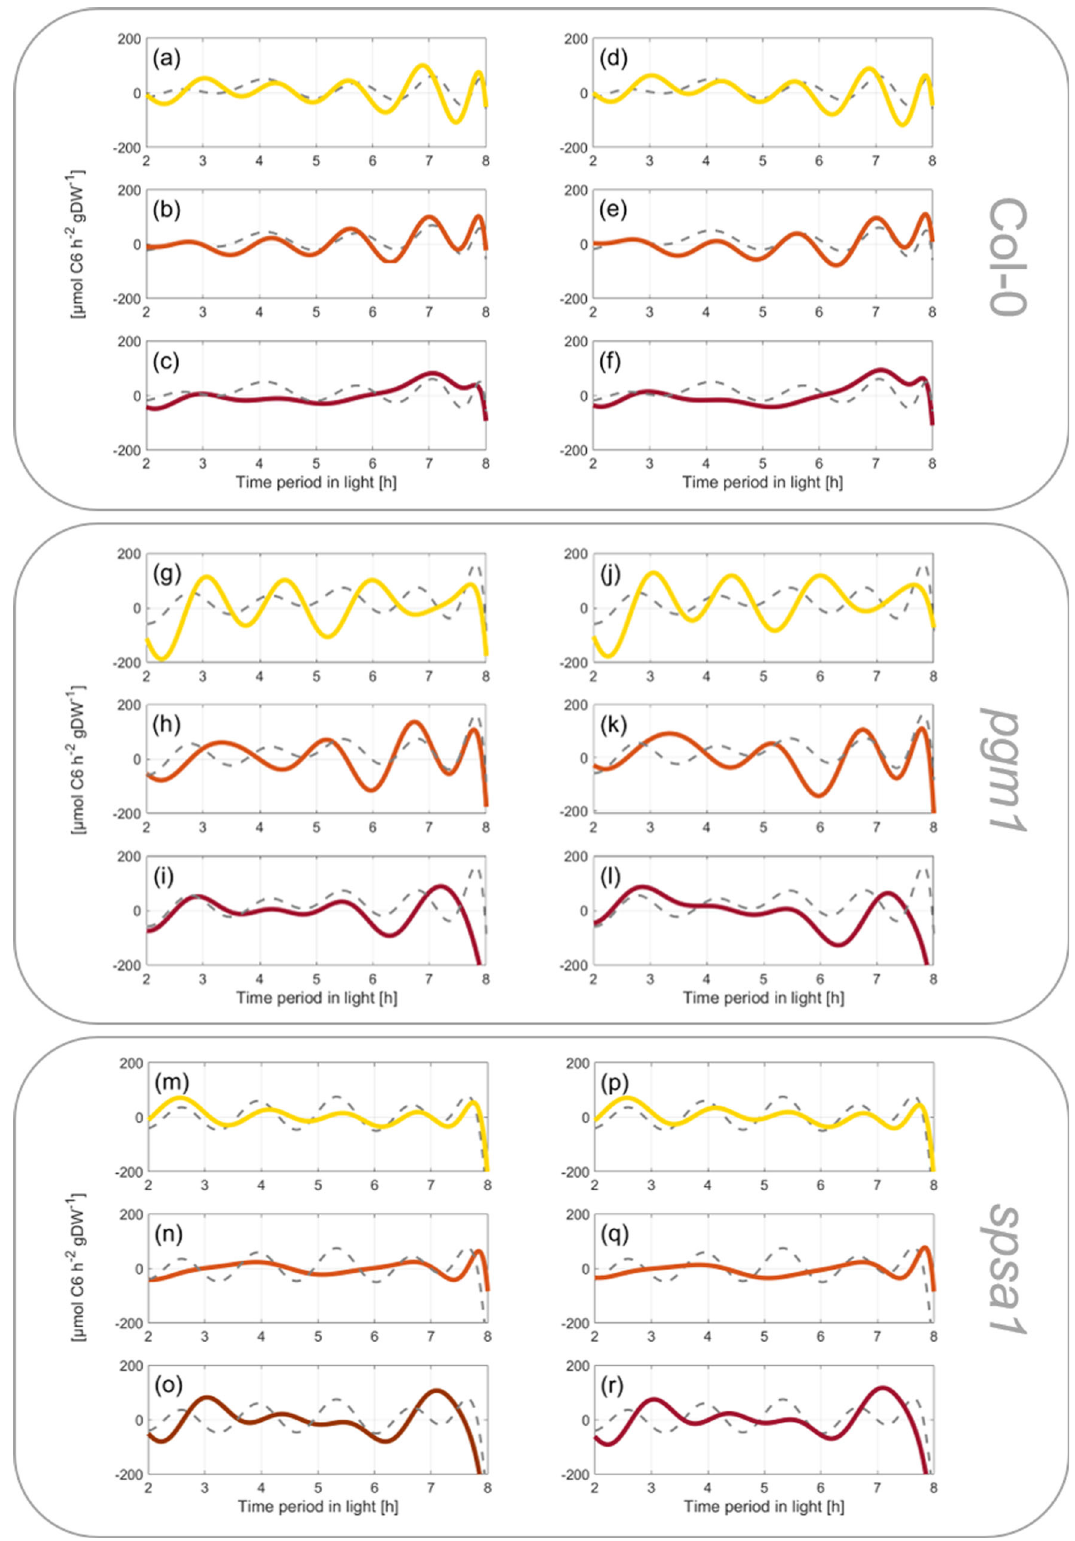
Fig. 8 Derivatives of carbon balance equations with respect to time. Derivatives of balance equations were built for the experiments “ 22 °C ” (control; gray dashed lines), “ 32 °C ” (yellow lines), “ 36 °C ” (orange lines), and “ 40 °C ” (red lines). Upper panel: Col-0, a – c derivatives of Col-0 balance Eq. (1) (BE 1 ), d – f derivatives of Col-0 balance Eq. (2) (BE 2 ). In the middle: pgm1 , g – i derivatives of pgm1 BE 1 , j – l derivatives of pgm1 BE 2 . Lower panel: spsa1 , m – o derivatives of spsa1 BE 1 , p – r derivatives of spsa1 BE 2